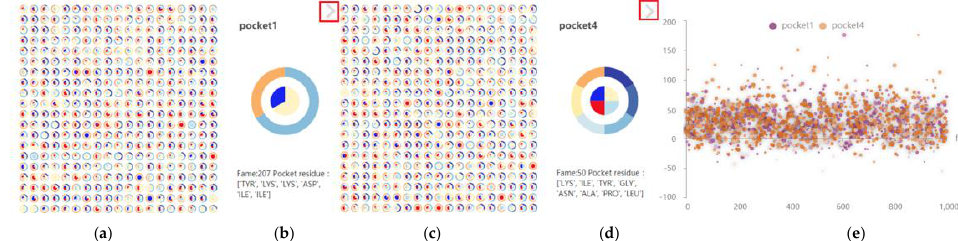
Figure 18. Comparison of other features of pocket 1 and pocket 4. Click the arrow in the red box to switch between pie chart and scatter chart. ( a ) Pocket 1 thumbnail. ( b ) Pocket 1 enlarged. ( c ) Pocket 4 thumbnail. ( d ) Pocket 4 enlarged. ( e ) Pocket 1 pocket 4 scatter